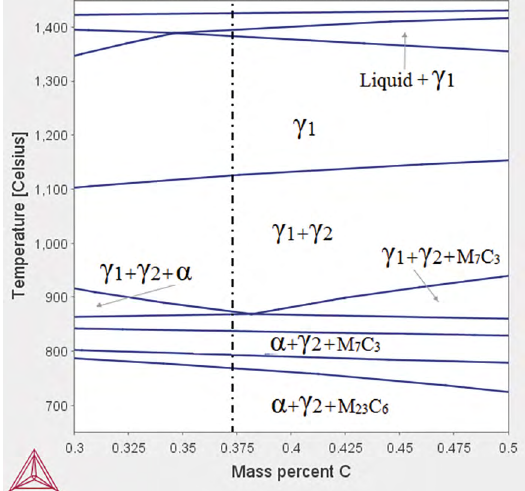
Figure 3. Phase diagram for the AISI H13 alloy (Thermocalc(r) software) according to the carbon content (wt.%). The dashed line indicates the composition of the samples processed in this study.